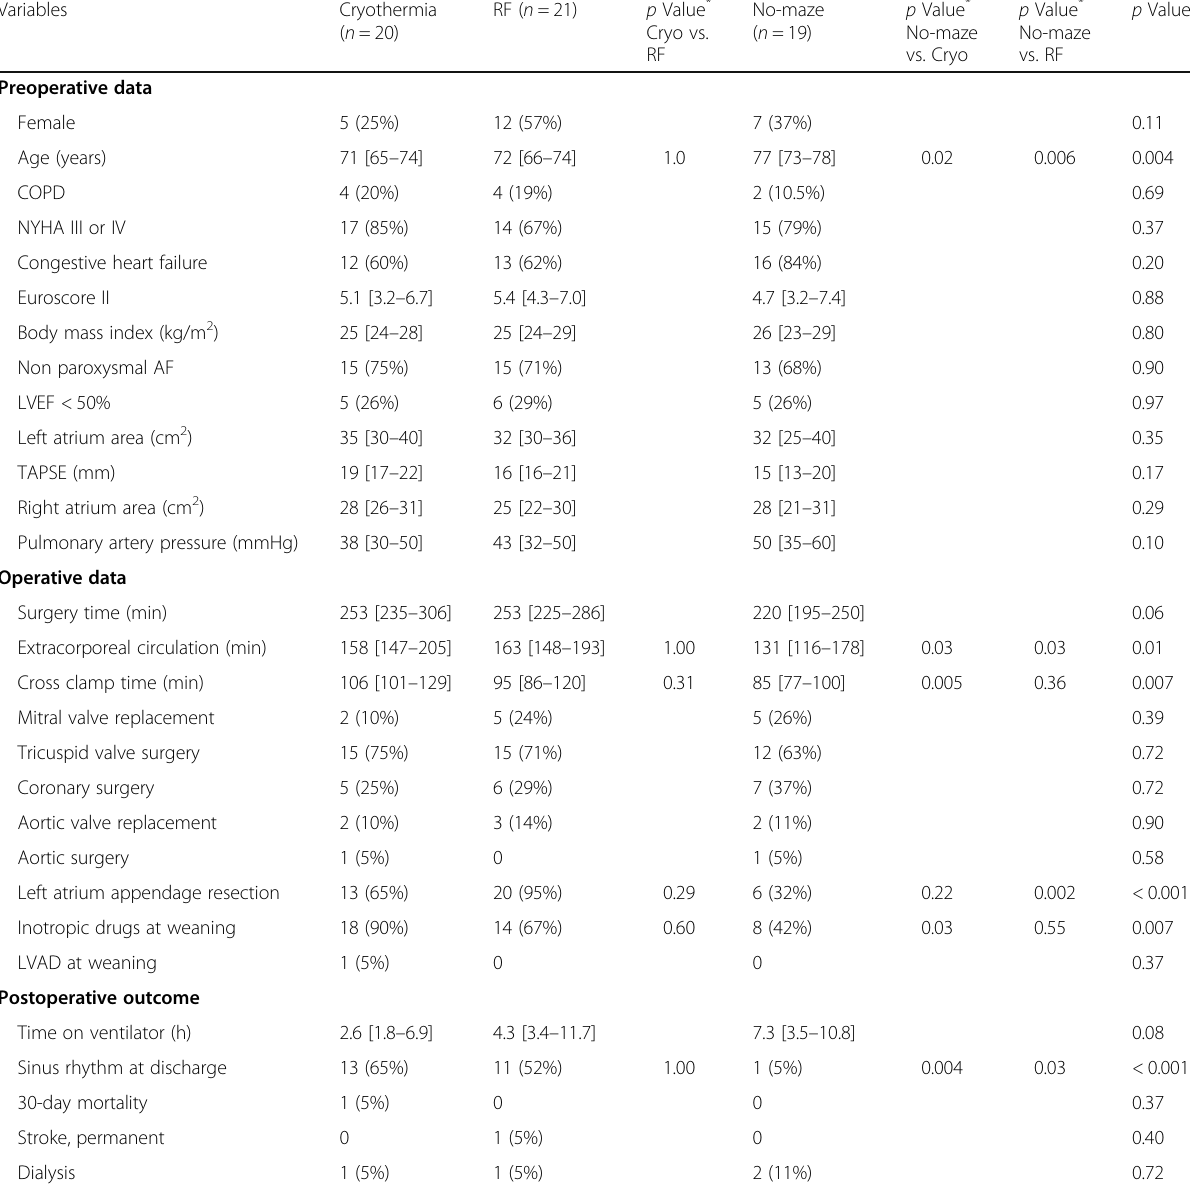
Table 2 Pre-, per- and postoperative data of the three study groups